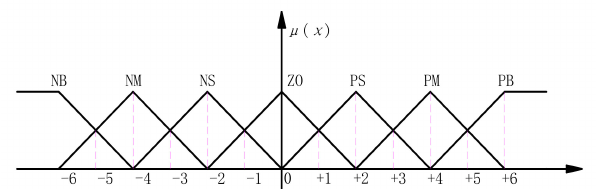
Figure 6. Membership function of e ( t + ∆ T ) and ∆ e CL ( t + ∆ T ) for cleaning loss and the louver sieve opening.